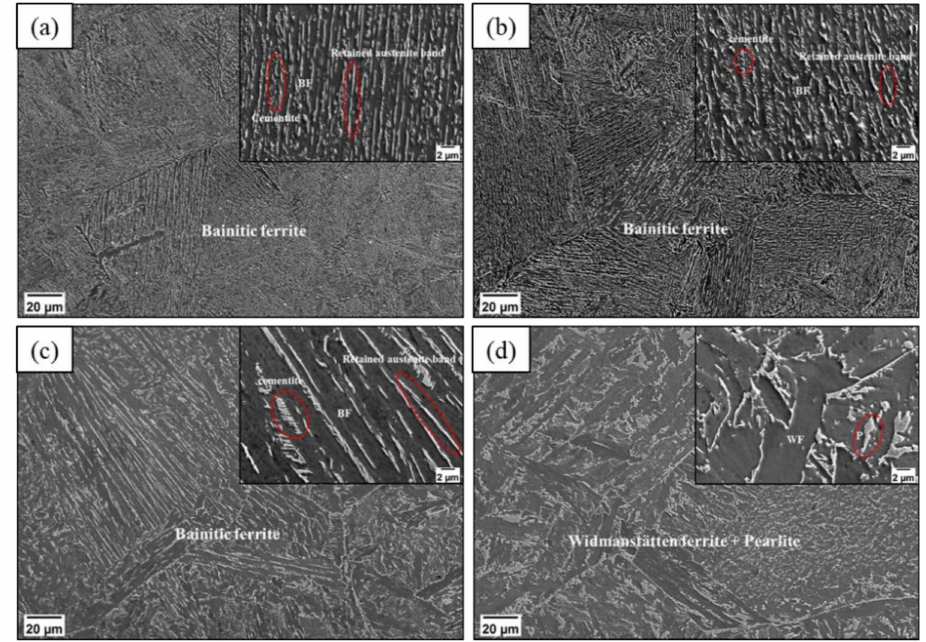
Figure 6. SEM micrographs of medium-carbon low-alloy steel isothermally heat treated for 240 min: hot-rolled steel heat treated at ( a ) 350 ◦ C, ( b ) 400 ◦ C, ( c ) 450 ◦ C, and ( d ) 500 ◦